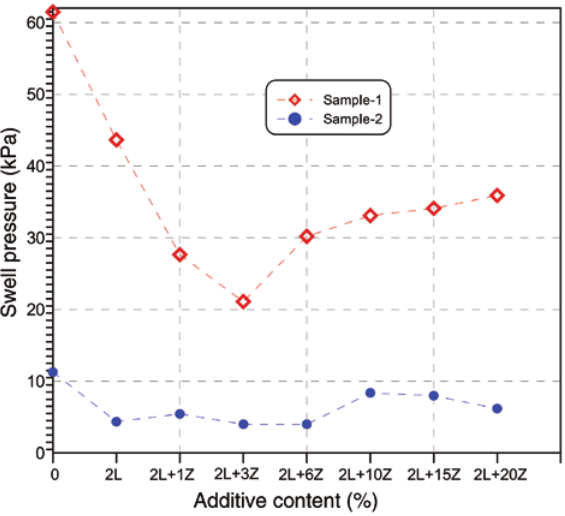
Figure 5: Relationship between additive content and swell pressure of the soil